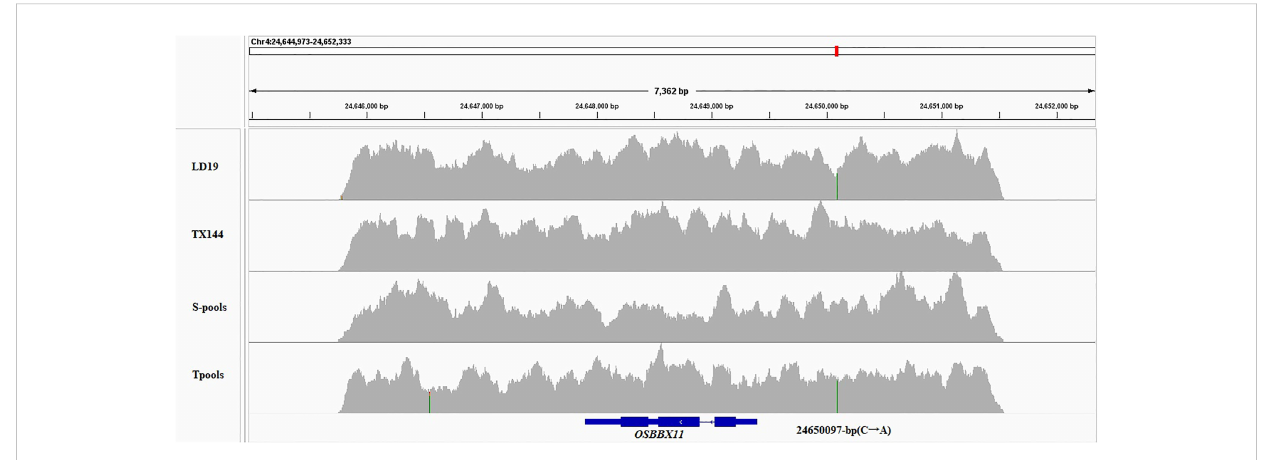
FIGURE 4 Visualization of variation information of OsBBX11 in four samples based on